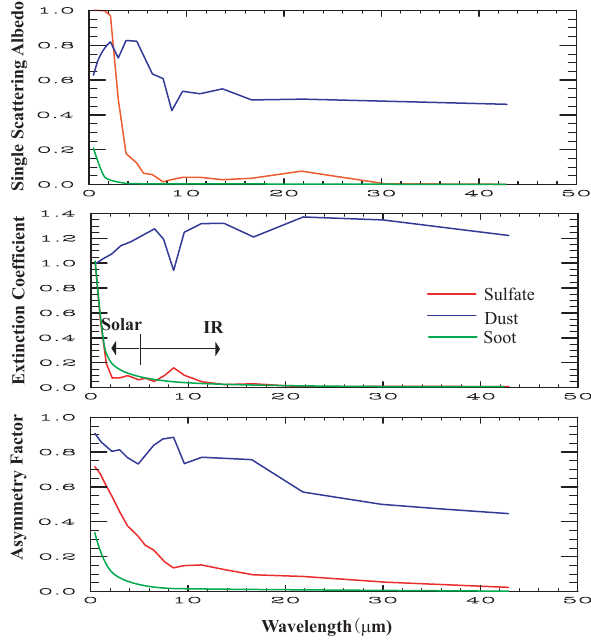
Fig. 2. Single scattering albedo (top panel), extinction coefficient (middle panel), and asymmetry factor (bottom panel) as a function of wavelength for sulfate (red), dust (blue), and soot